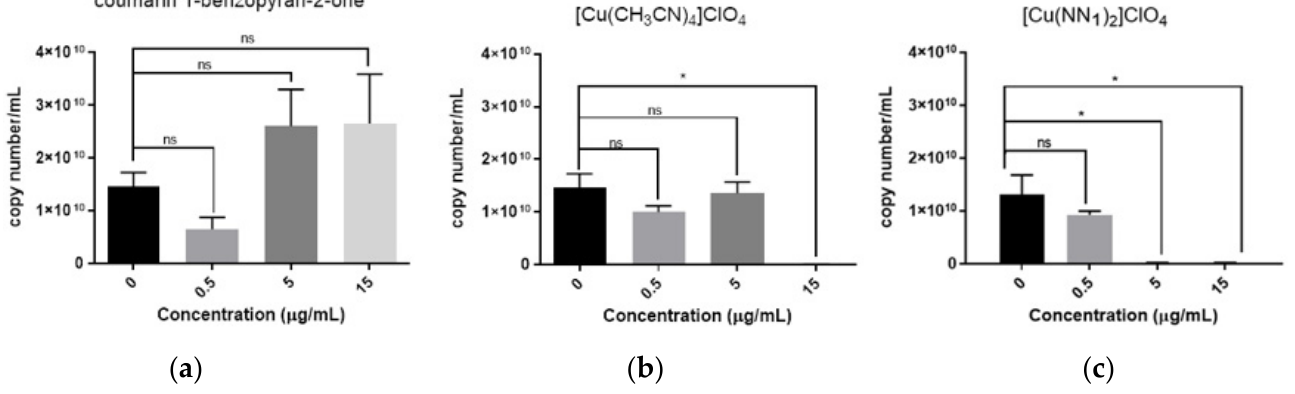
Figure 3. Antiviral activity against IPNV of test compounds in CHSE-214 cells. IPNV was incubated for 24 h with 0.5, 5.0, and 15.0 µ g/mL of ( a ) coumarin, ( b ) [Cu(CH 3 CN) 4 ]ClO 4 , ( c ) [Cu(NN 1 ) 2 ]ClO 4 complex, after that CHSE-214 cells were treated for 24 h with IPNV. RNA total extraction was performed from the cell cultures and viral load was determined by quantitative real-time PCR with three technical replicates. Statistical differences were determined by one-way ANOVA test (* p < 0.05; ns = non-significant).